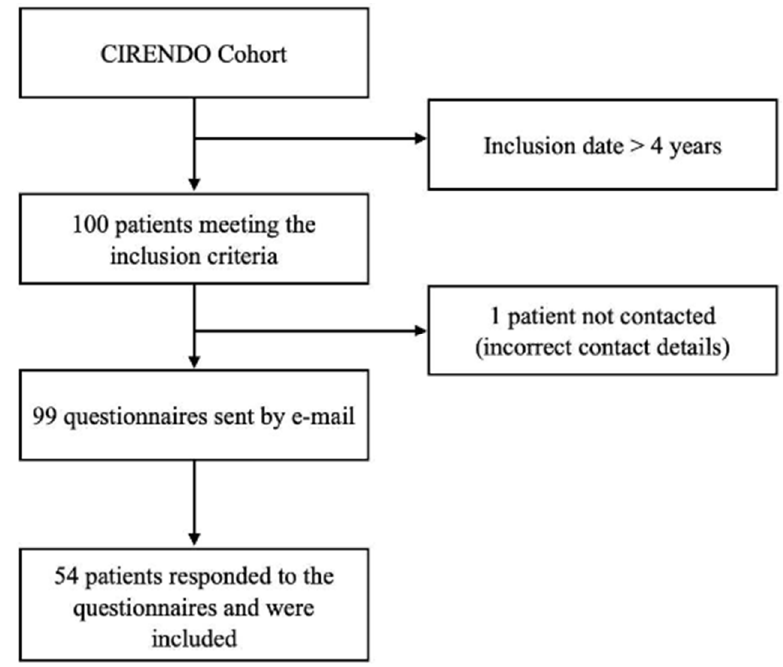
Figure 1. Flowchart for the selection of the study group.